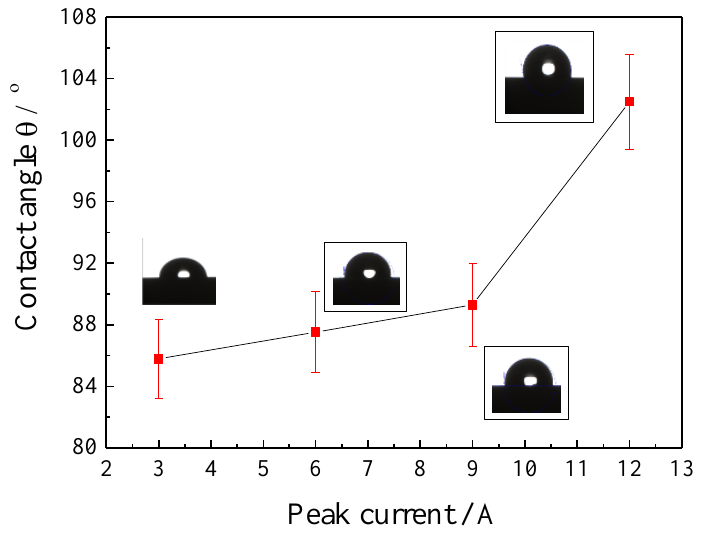
Figure 4. Contact angle of a sodium chloride solution droplet on modified layers machined with different peak currents and the non-treated surface.